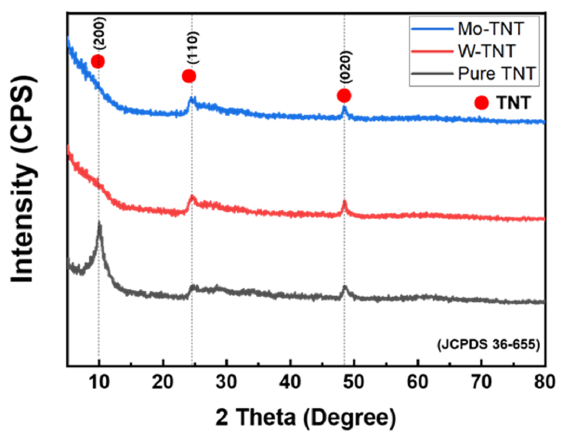
Figure 1. XRD patterns of synthesized Pure TNT, Mo-TNT, and W-TNT.